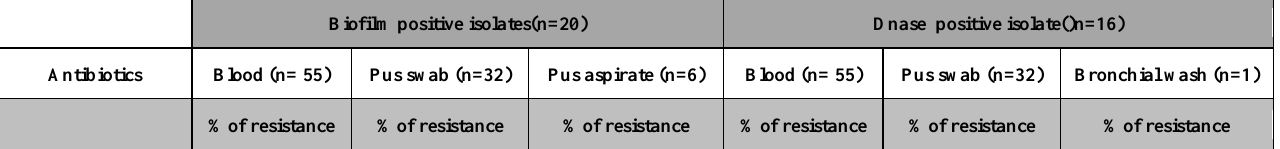
Table 7. Distribution of virulence factors and antibiotic sensitivity patterns in clinical